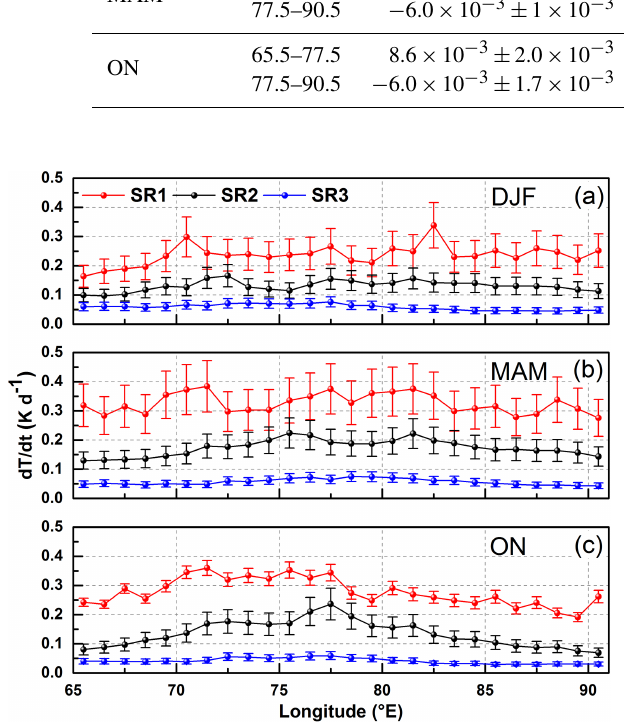
Figure 7. Zonal variation in columnar atmospheric heating rates (d T / d t ) for (a) DJF, (b) MAM, and (c) ON seasons. The error bars represent the standard